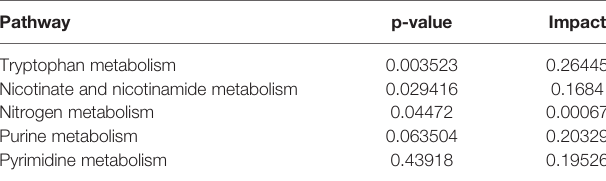
TABLE 1 | Impact of IDO1 on metabolism pathways.